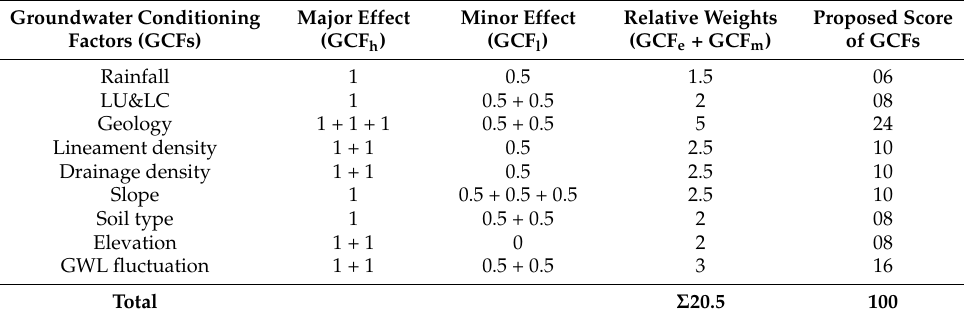
Figure 4. Interrelationship between the GCFs concerning the GW pot index.